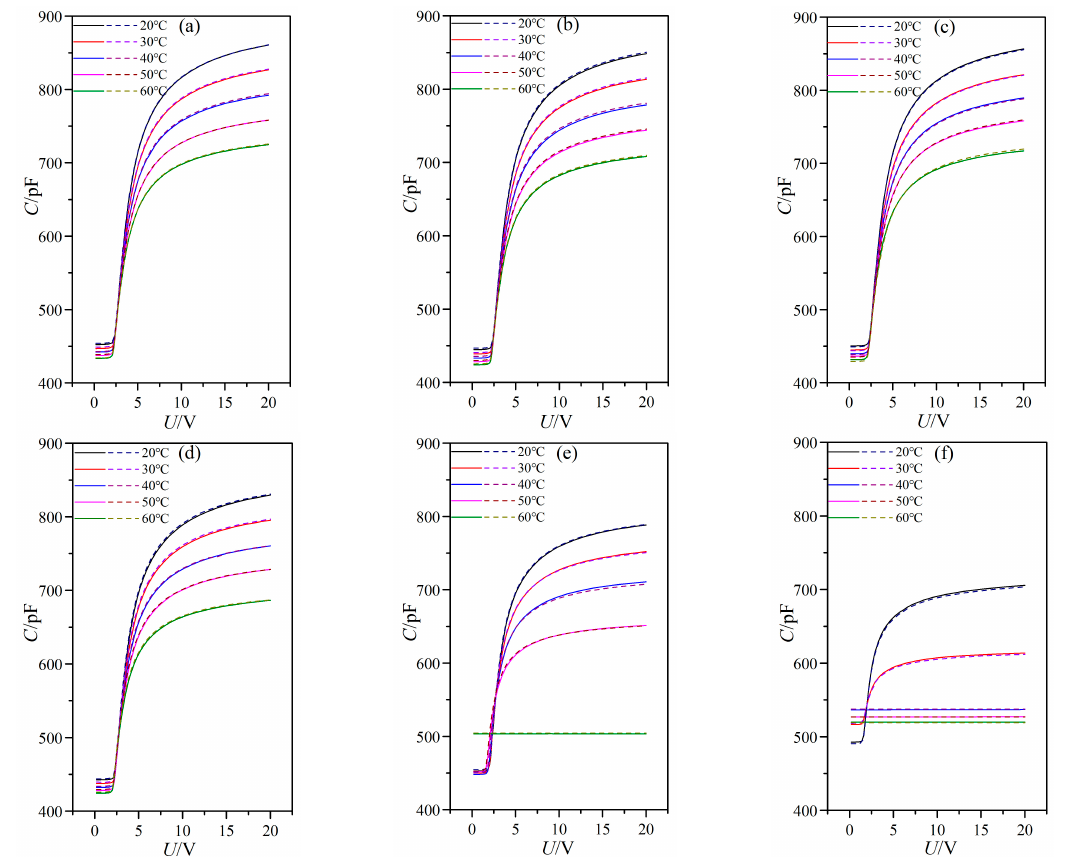
Figure 11. LC cell capacitance versus voltage with frequency of 1 kHz for PAN cell under different temperatures and doped γ -Fe 2 O 3 nanoparticle concentrations of ( a ) 0.0 wt %; ( b ) 0.02 wt %; ( c ) 0.048 wt %; ( d ) 0.145 wt %; ( e ) 0.515 wt %; and ( f ) 0.984 wt %. Solid lines for the original data and dashed lines for the data a month later.